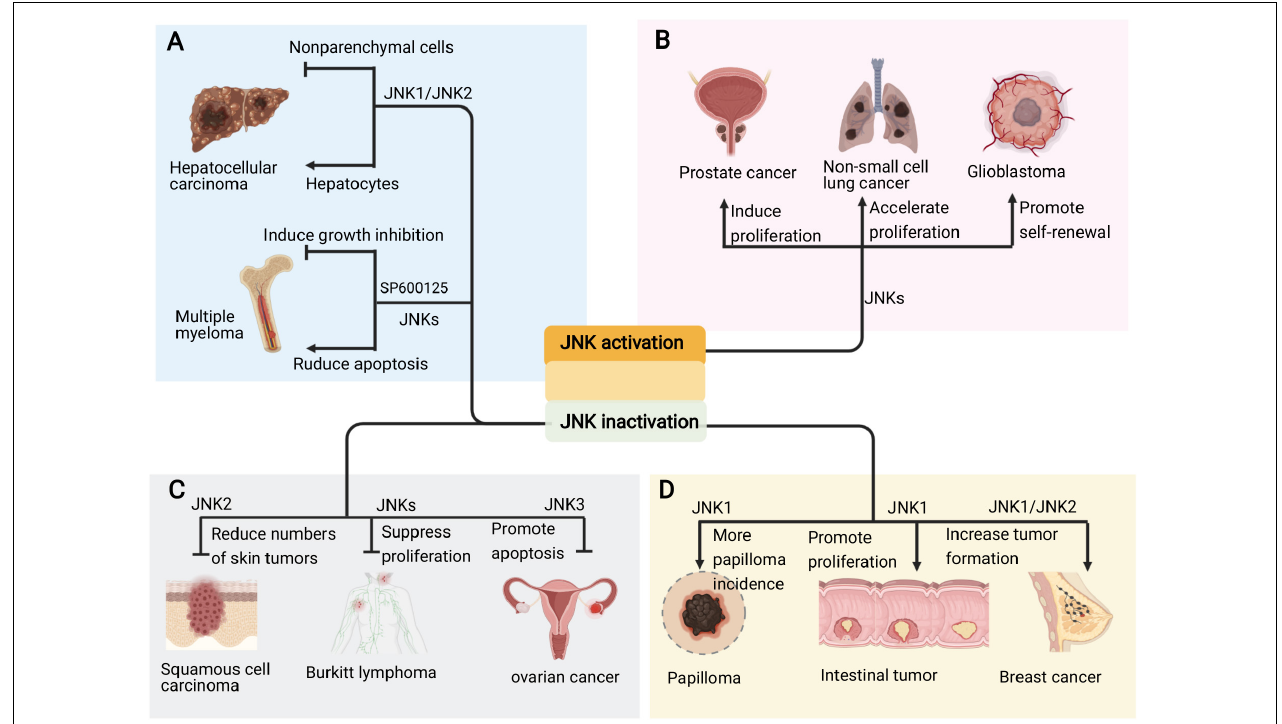
FIGURE 5 | Pro and anti-oncogenic roles of JNK signaling in cancers. (A) The JNK signaling plays due role in the occurrence of different kind of cancers. (B) Sustained activation of JNKs promotes the development and progression of cancers such as prostate cancer, non-small cell lung cancer and glioblastoma. (C) Inhibition of different JNKs also suppresses skin cancer, lymphoma and ovarian cancer. (D) However, deficiency or inhibition of JNK, especially JNK1, also cause intestinal tumor, papilloma and breast